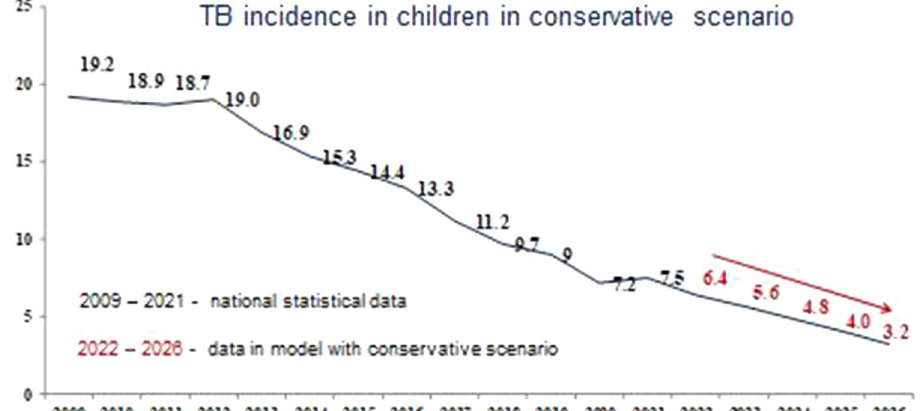
Fig. 5 Forecast of the